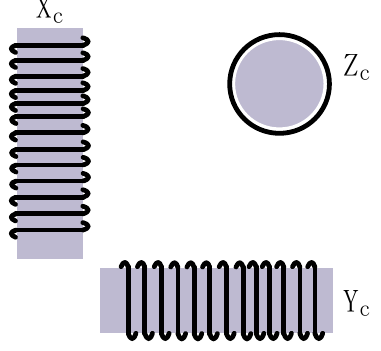
Figure 1. Coil layout of the magnetic induction sensor.